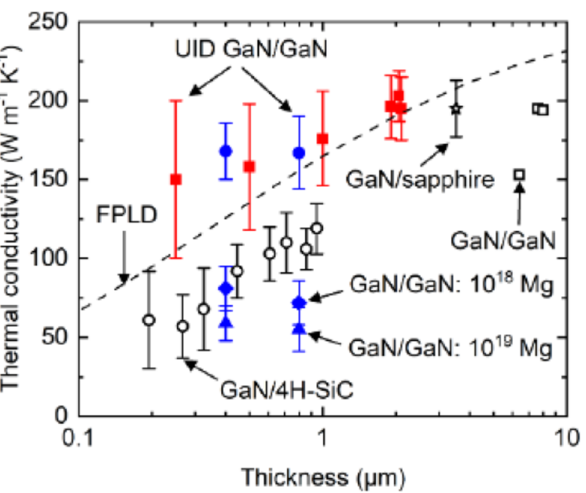
Figure 7. Room temperature thermal conductivity of MBE (blue) and MOCVD (red) films as a func- tion of thickness. Reprinted figure with permission from [27]. Copyright 2022 by the American Phys- ical Society.